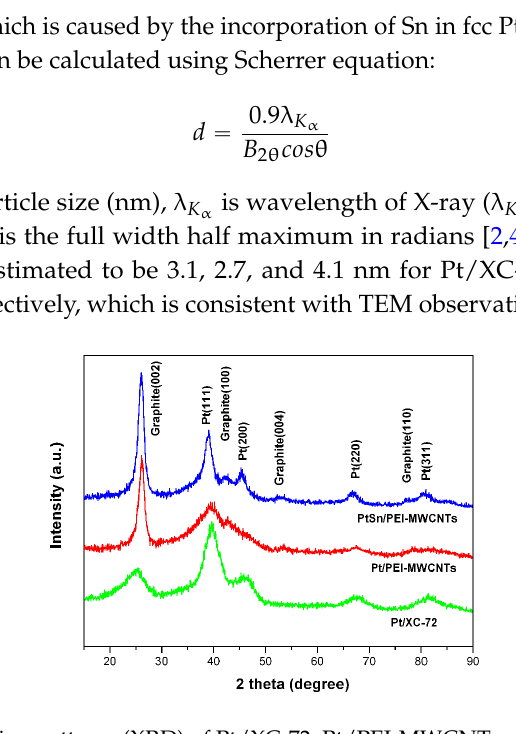
Figure 6. X ‐ ray diffraction patterns (XRD) of Pt/XC ‐ 72, Pt/PEI ‐ MWCNTs and PtSn/PEI ‐ MWCNTs.